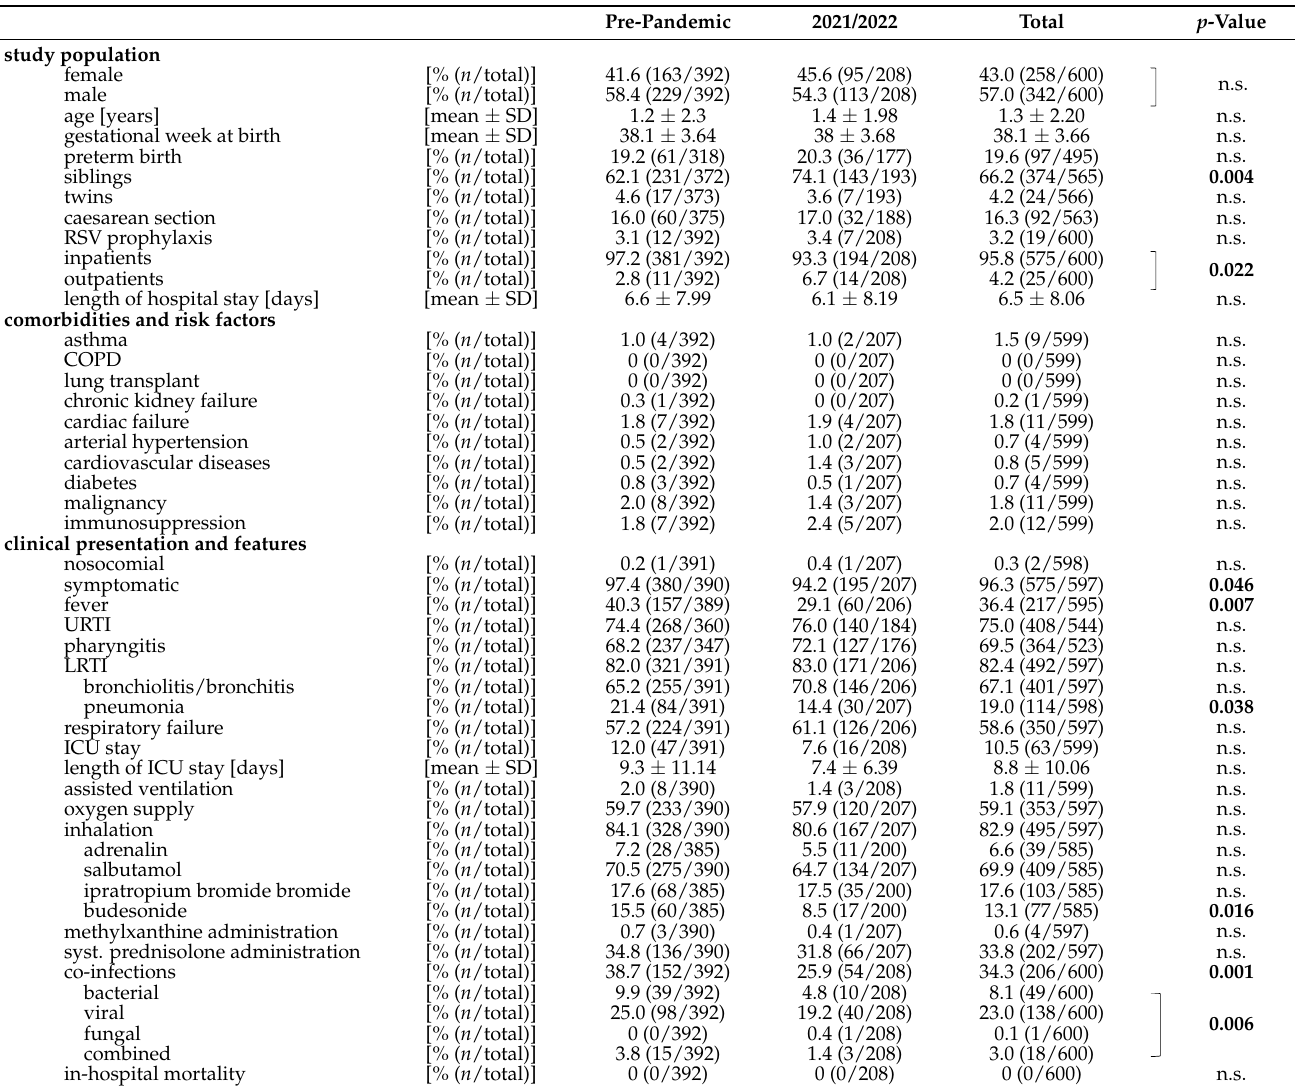
three pre-pandemic seasons, significantly more pediatric cases were observed in season 2021/2022 (Table 1, p < 0.001 in comparison to all other seasons). The relative age stratification of RSV cases by season is shown in Figure 3. Table 2. Study population and clinical features of pediatric RSV cases. Table 1. Gender, age, and RSV species distribution during the study period.